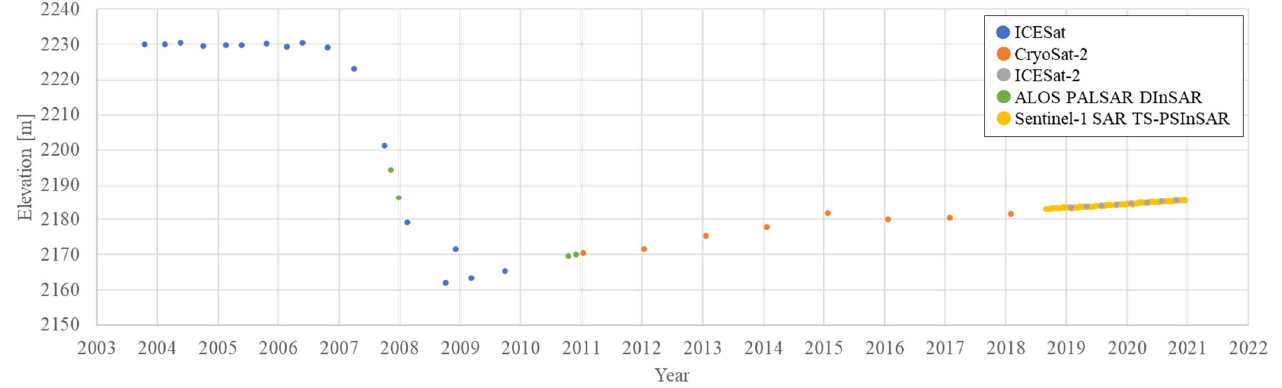
Figure 14. Comprehensive time ‐ series result of elevation changes.